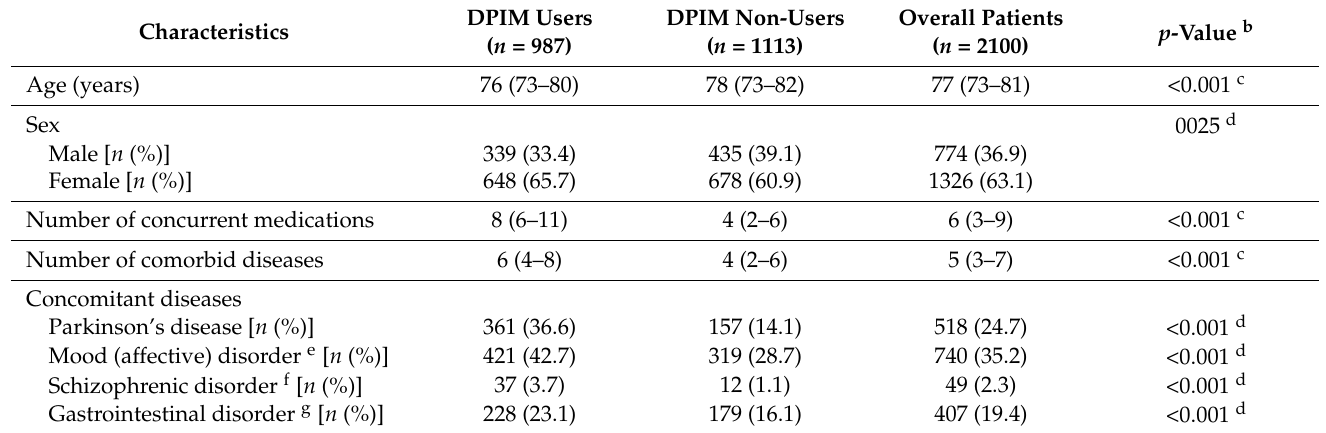
Table 2. Baseline characteristics of patients included in this study a .